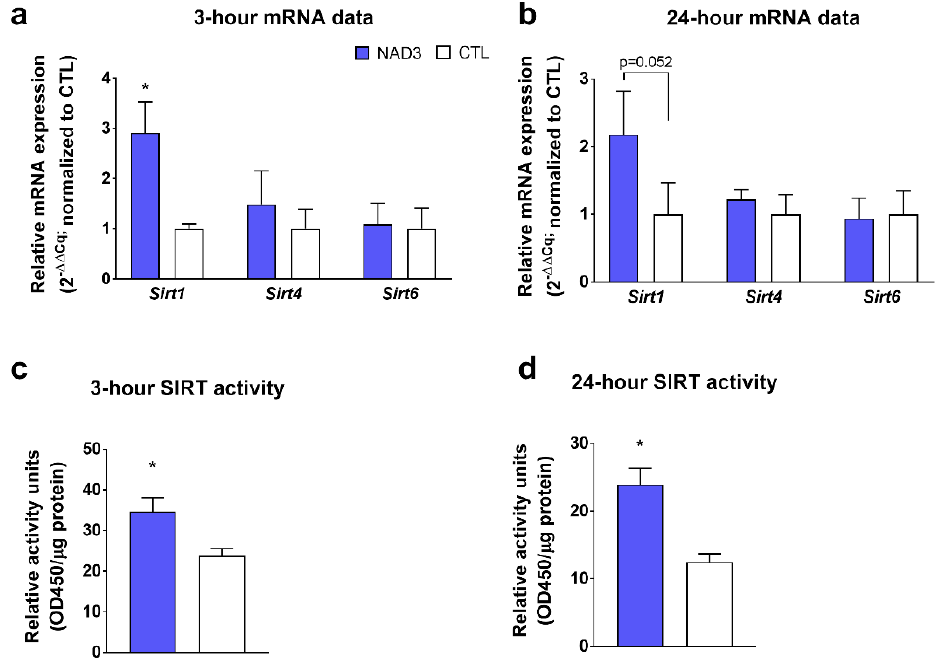
Figure 1. E ff ects of experimental (NAD3) treatments on sirtuin (SIRT) markers. These data Figure 1. Effects of experimental (NAD3) treatments on sirtuin (SIRT) markers. These data illustrate